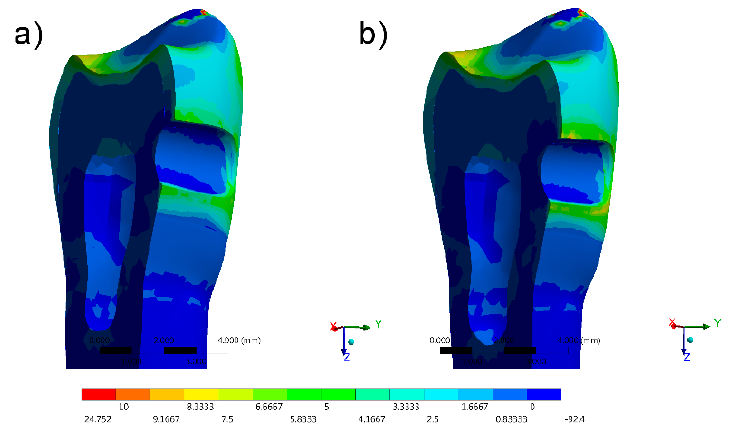
Figure 5. FEA Maximum Principal Stress results in the mesio-occlusal design. ( a ) Bulk-fill flowable and ( b ) conventional.